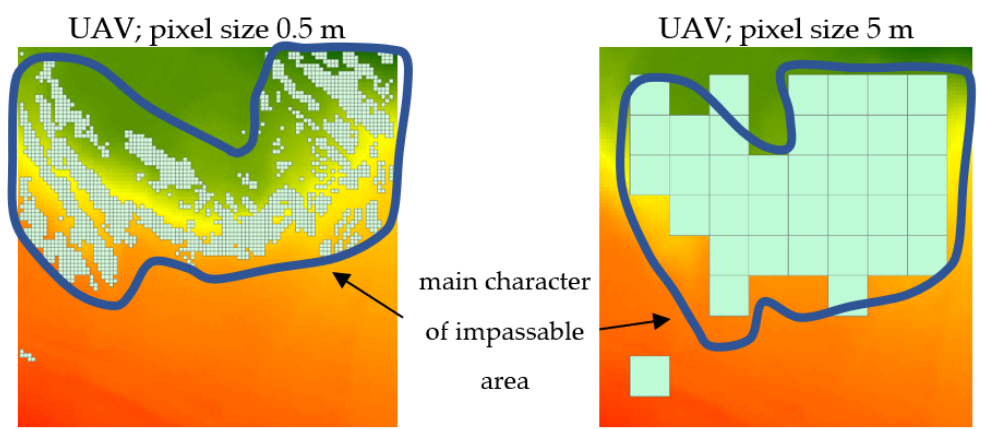
Figure 18. Impassable areas and the indicated main characteristics.